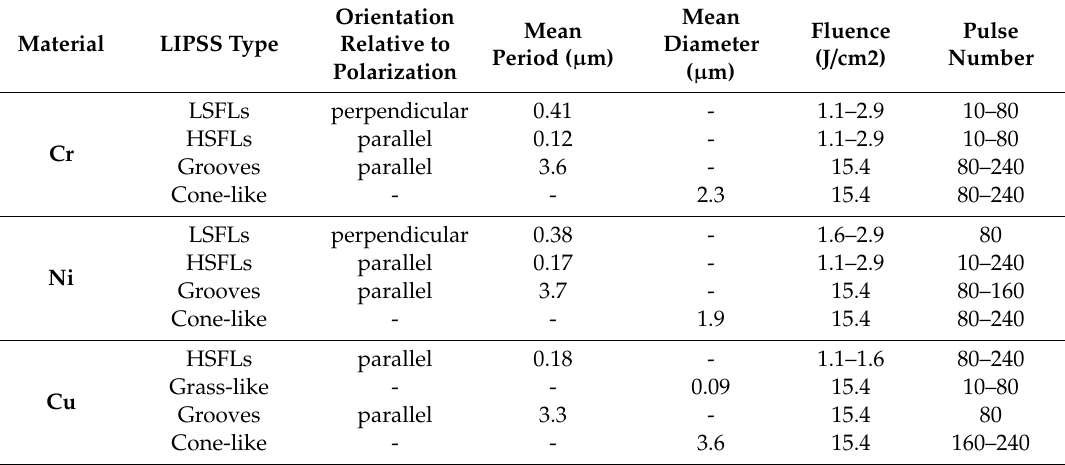
Table 2. Summary of types, orientation relative to radiation polarization, and period of LIPSS on irradiated Cr, Ni, and Cu surfaces with varying laser fluence and number of pulses.